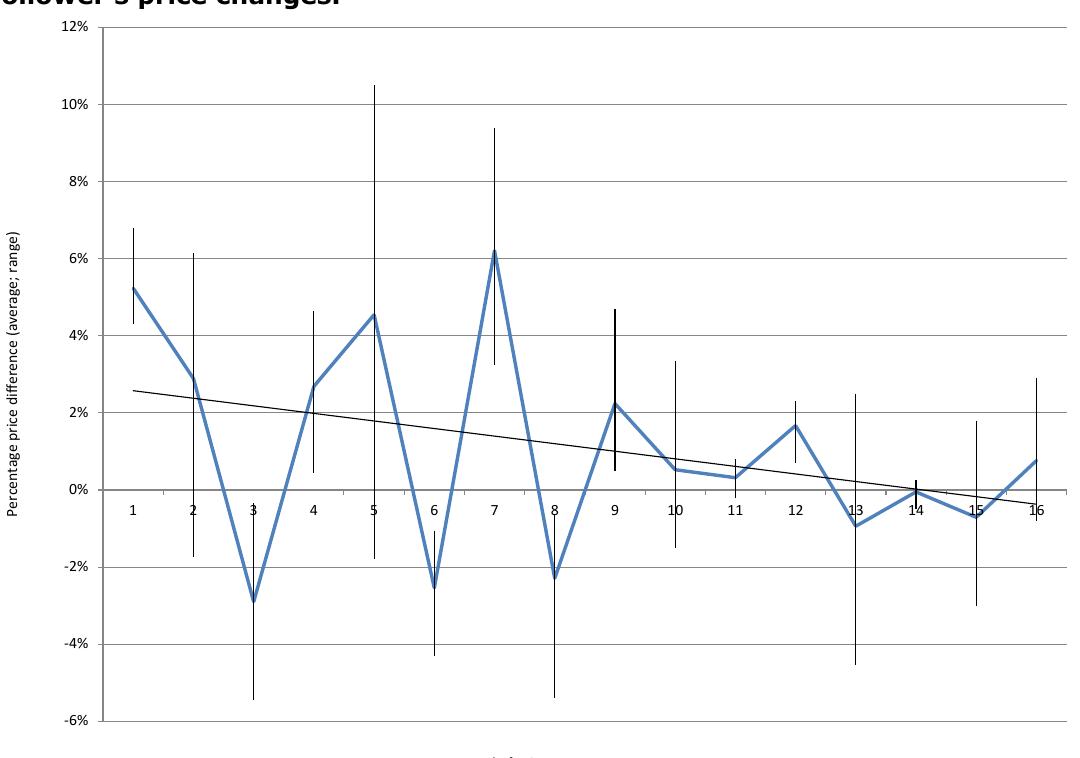
Figure 33: Average difference between price change by round leader and follower’s price